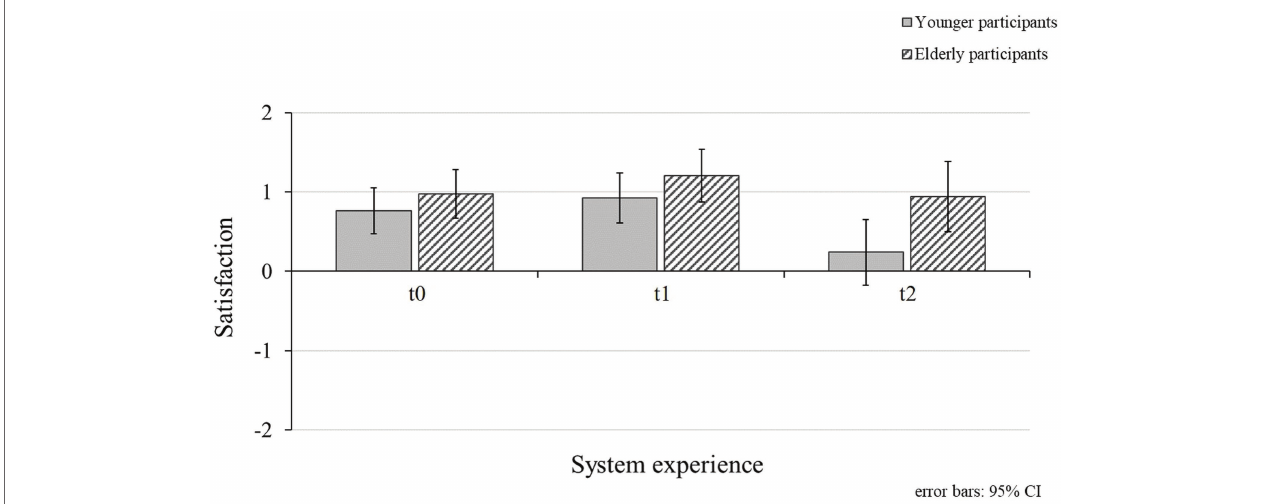
FIGURE 7 | Mean values for younger and elderly participants’ satisfaction ratings for the different points of measurement (t0 = initial measurement; t1 = valid system functions; and t2 = valid and invalid system functions). Higher values represent higher satisfaction